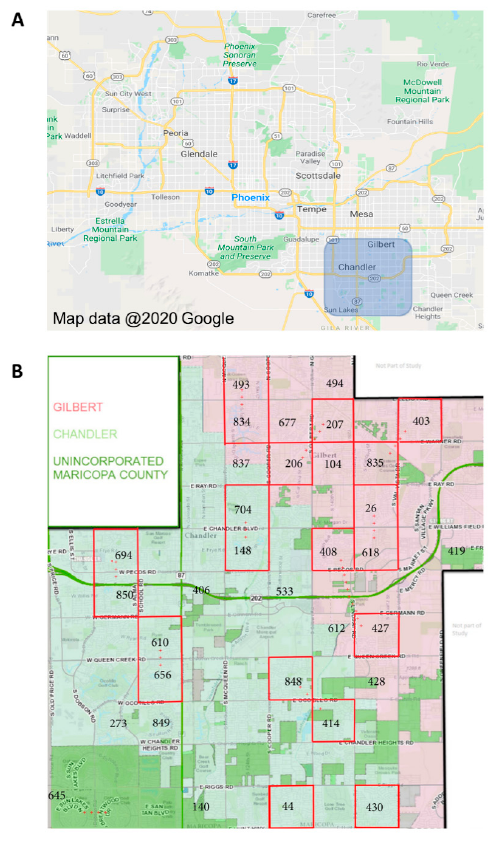
Figure 2. Location of field collections of Ae. aegypti mosquitoes in Maricopa County, Arizona. Aedes aegypti mosquitoes were collected during the monsoon seasons (approximately July through Octo- ber) in southeastern Maricopa County and included the cities of Chandler, AZ, and Gilbert, AZ ( A ). Mosquitoes were collected from 20 paired collection sites ( B ) using BG sentinel traps (3 traps dis- tributed per site) for one night each week throughout the collection period. A total of 201 female Ae. aegypti in 2017 and 172 in 2018, representing ~15% of the total number of females collected, were used for parity analysis and SCP1 /NIRS age